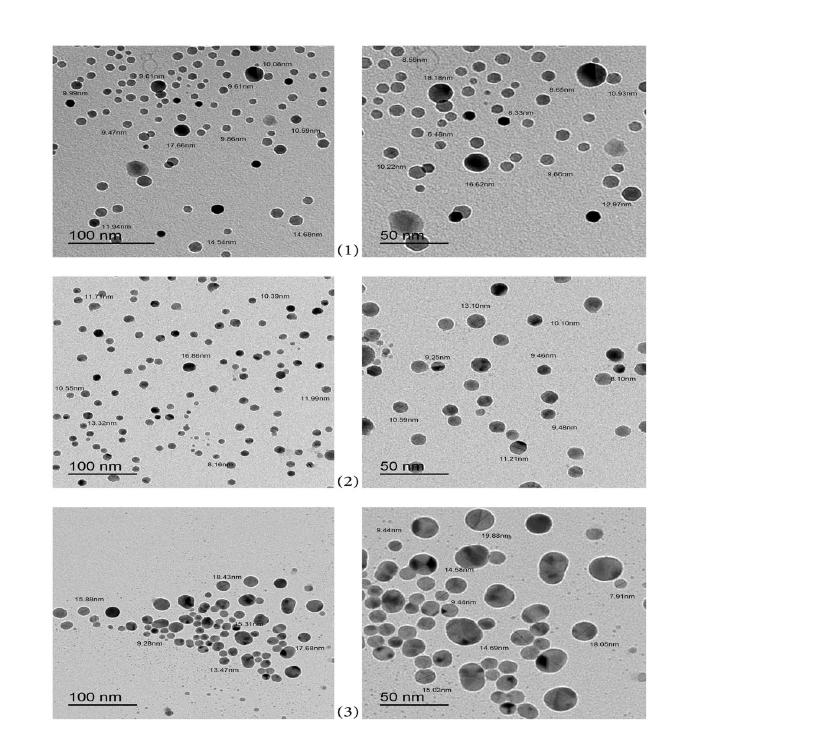
PLOS ONE | https://doi.org/10.1371/journal.pone.0257071 September 10,